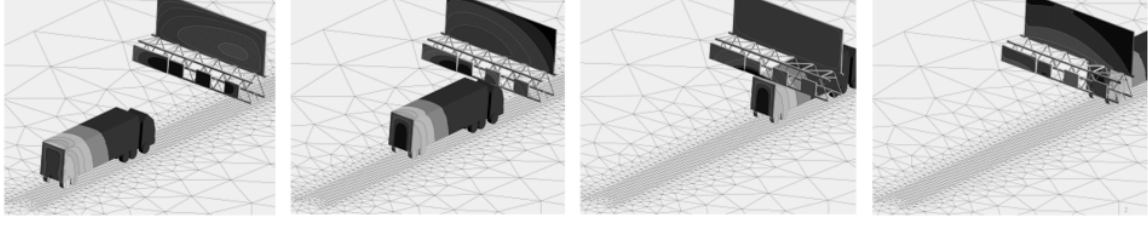
Figure 10. ( a ) Typical passage of an HSV under portal gantry for field study [39] and ( b ) CAD model of HSV and partial gantry boom.